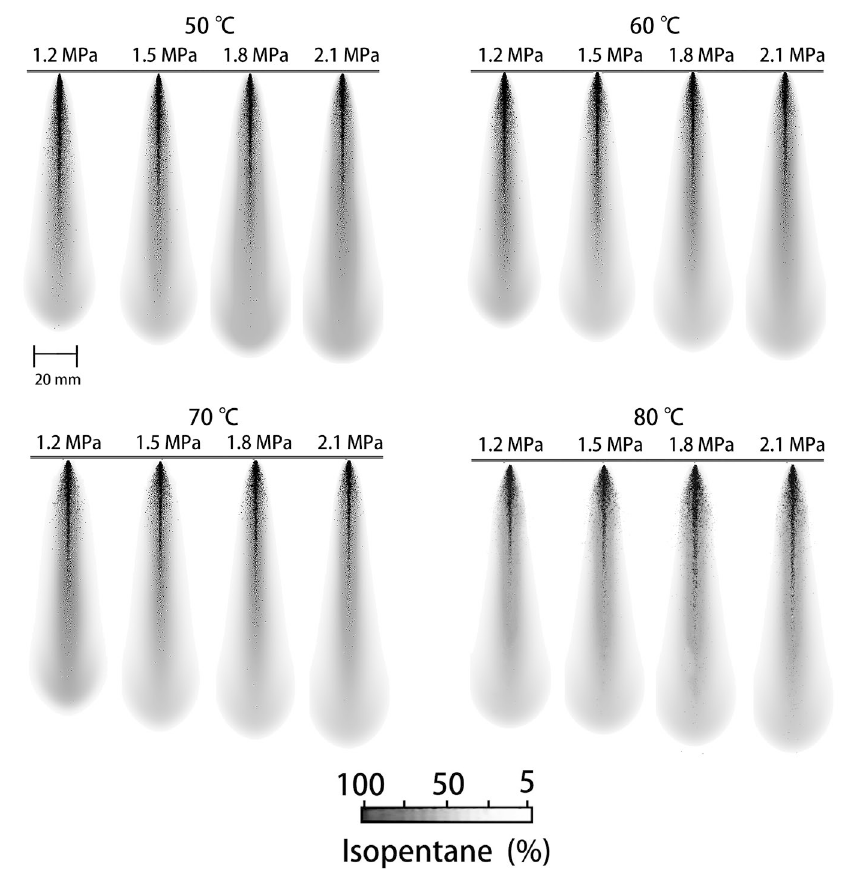
Figure 5. Overall spray morphology of iso-pentane flashing spray at varied T inj (50–80 ◦ C) and P inj (1.2–2.1 MPa).